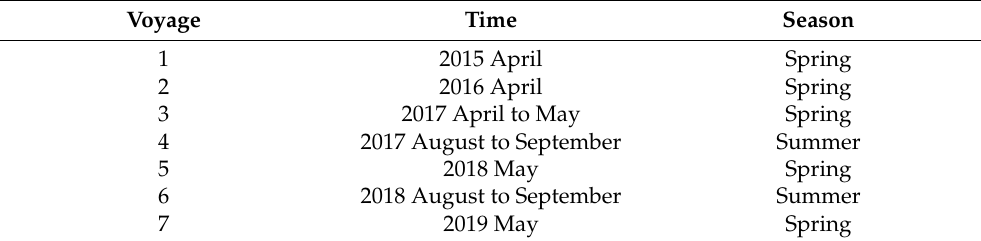
Table 1. Survey sampling times.